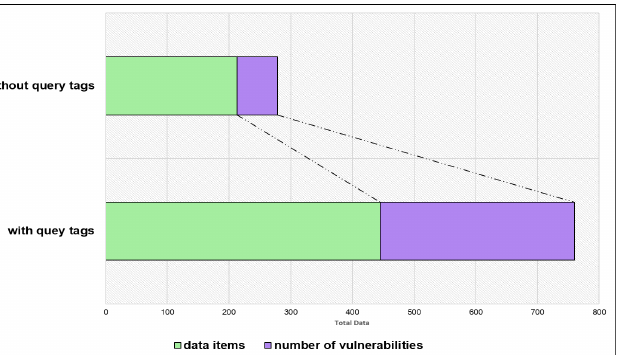
Figure 2. Number of data items and vulnerabilities when Query Tag is displayed in Shodan. The trend is directly